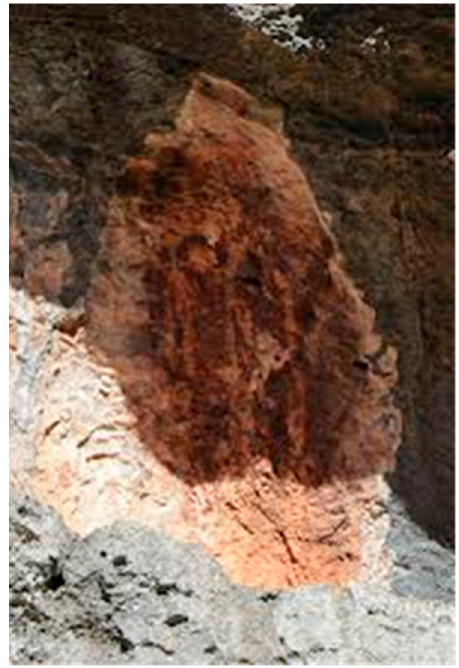
Figure 27. Shelter IV. Three images together, a “family”, inside a cave. This photo was taken by the author.